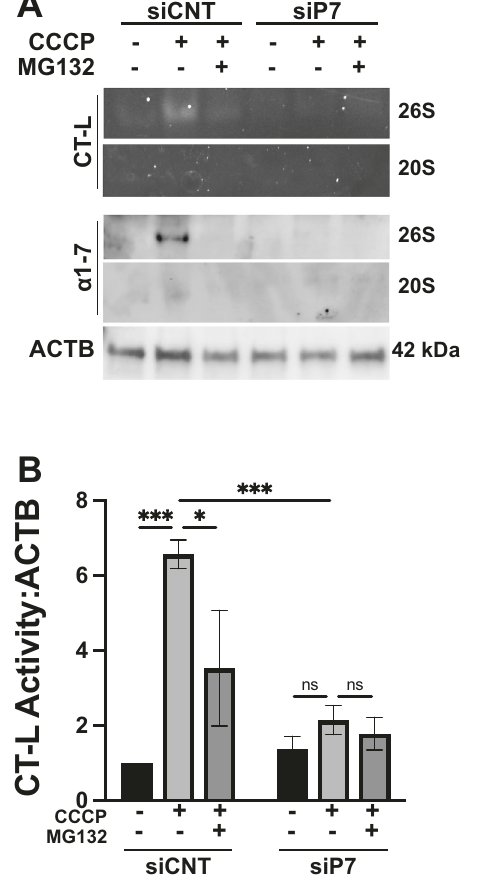
Fig. 6 Knockdown of PSMA7 alters CCCP-induced assembly of the proteasome subunits and proteasome activity. A Representative native gel (upper two panels) and western blot (lower two panels) images of the 26 S and 20 S subunits of the proteasome in HA- PARK2 expressing HEK 293 T cells transfected with control siRNA (siCNT) or PSMA7 siRNA (siP7), and treated with DMSO or CCCP (20 µM) for 2 h in the absence or presence of proteasome inhibitor MG132 (2.5 h, 30 µM). Actin beta (ACTB) was used as loading control. B Graph representing the in-gel chymotrypsin (CT-L) proteasome activity from A (mean ± SEM, n =